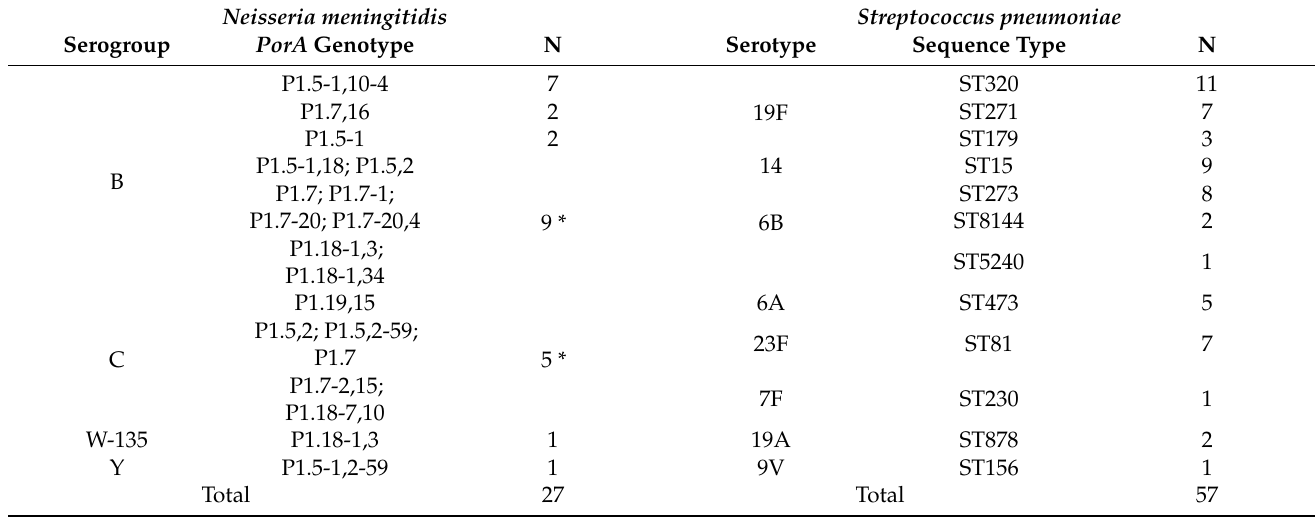
Table 2. Molecular characterization of isolates of N. meningitidis and S. pneumoniae . Neisseria